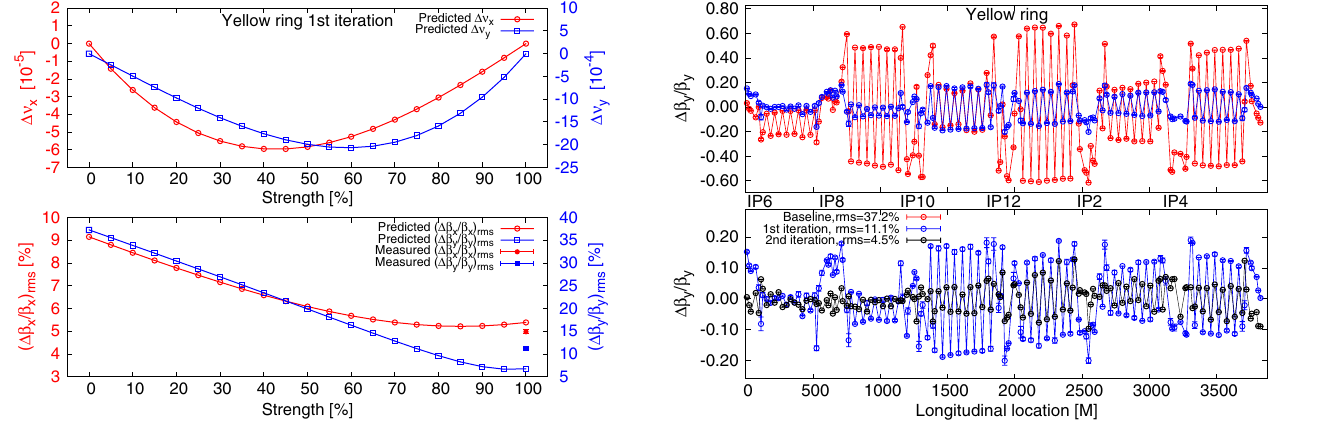
FIG. 6. Simulated evolution of tunes and rms beta-beat along a ramp-up process of the computed first iteration of corrections for the Yellow ring. The measured rms beta-beat with error bars at 100% of correction strength is also shown.